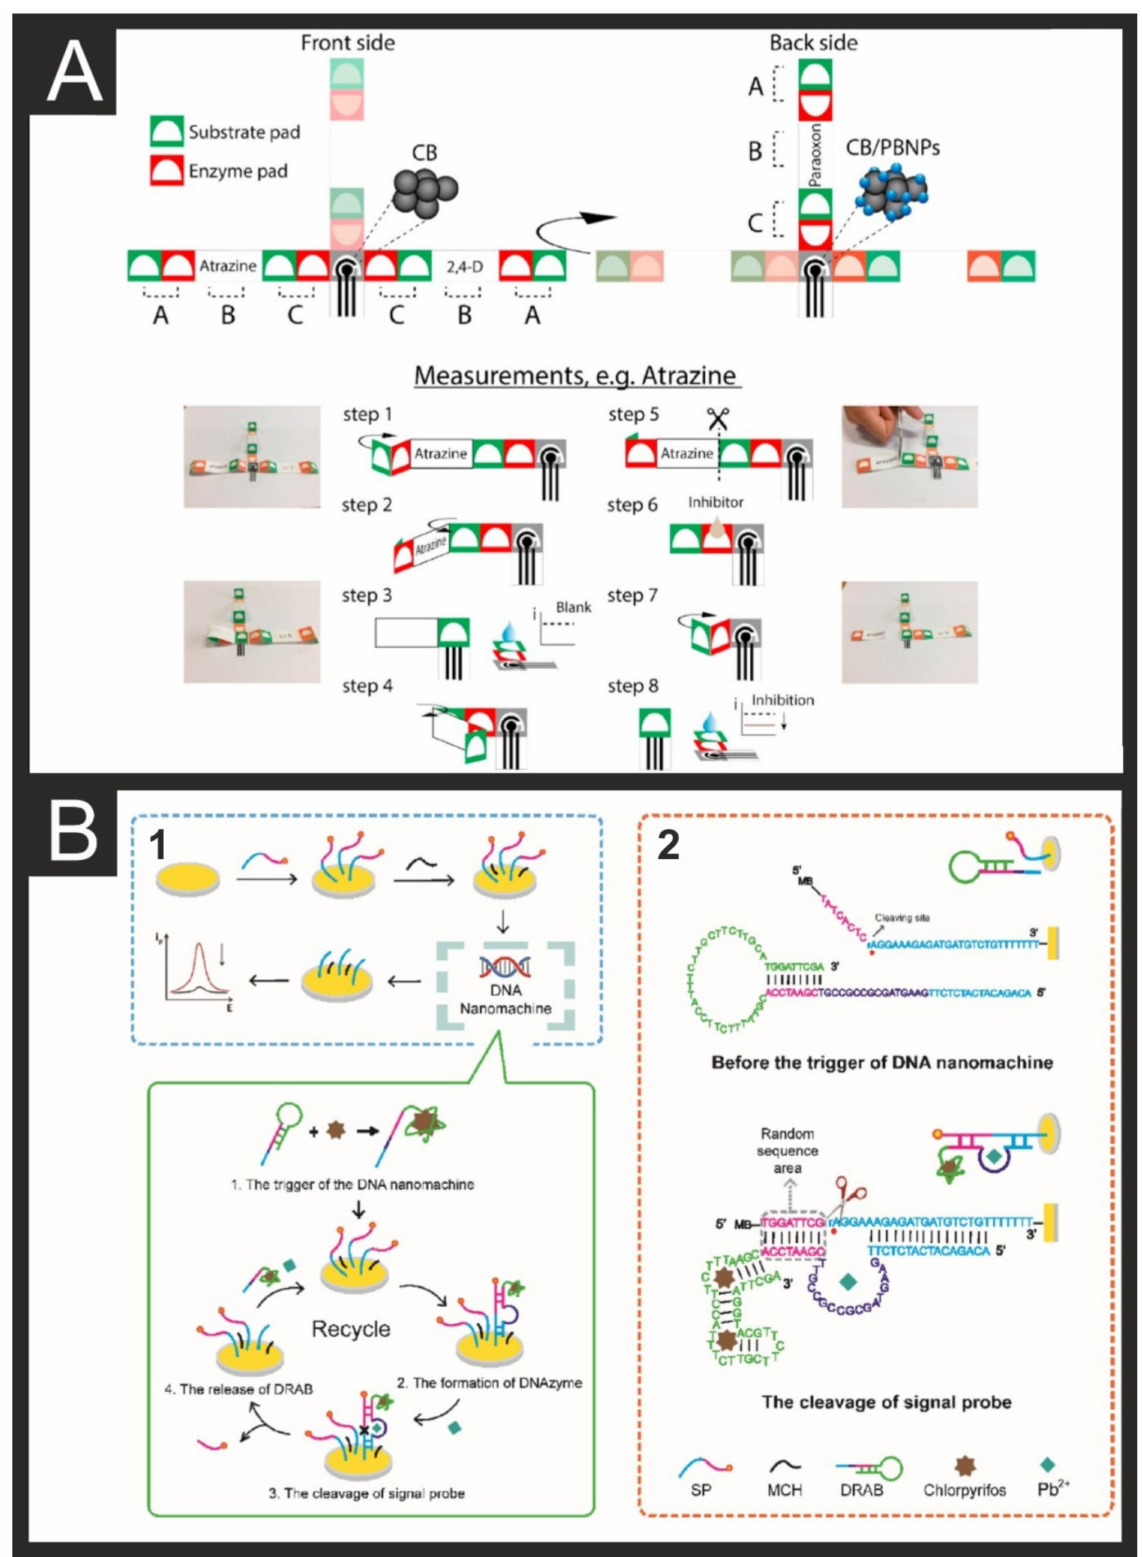
Figure 7. ( A ) Schematic representation and photographs of the configuration of the paper-based platform and measurement procedure. ( B ) The principle of DRAB-based electrochemical biosensors (1) Modification and detection procedure of the proposed sensor. (2) The secondary structure of the